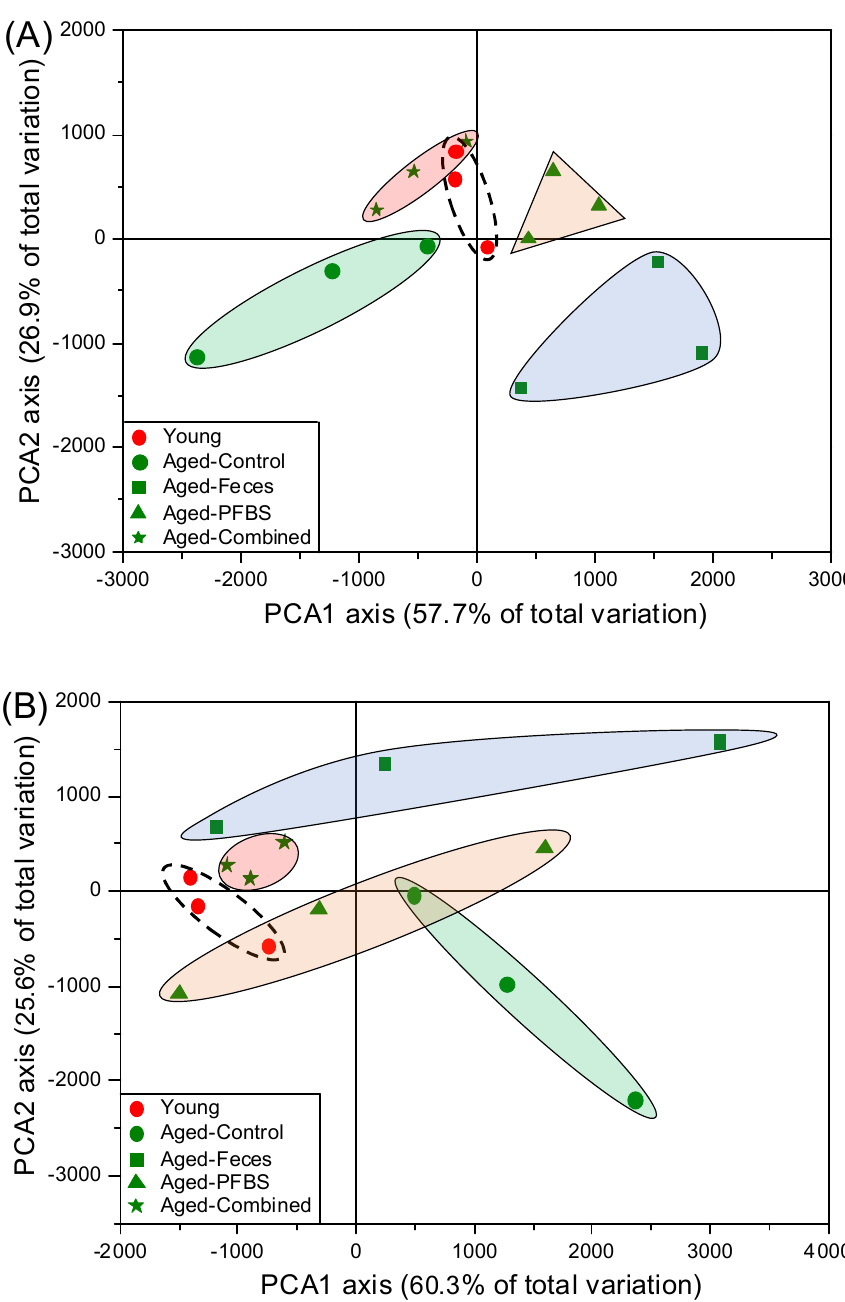
Figure 3. Principal component analysis (PCA) in male ( A ) and female ( B ) zebrafish, with the input of differential genes based on the variance–covariance matrix.